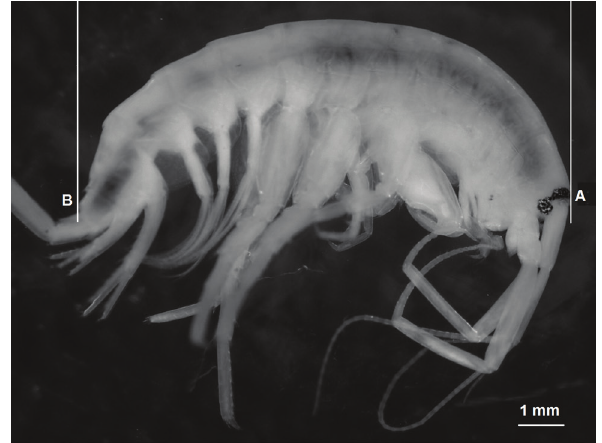
Figure 1. Body length (BL) with the natural curvature of the body, measured from point A (rostrum) to point B (end of the third segment of the urosome) in Quadrivisio lutzi .